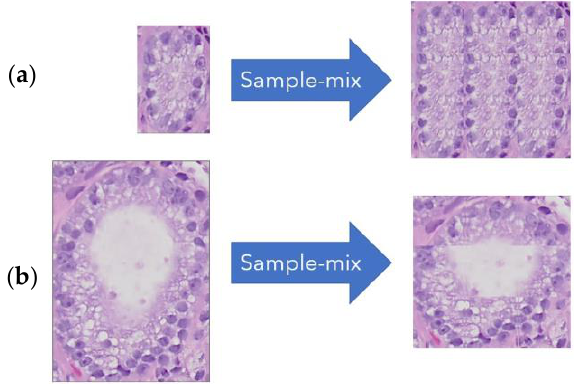
Figure 4. Sample-mix rescale examples: ( a ) 126 × 188 -> 300 × 300, ( b ) 290 × 417 -> 300 × 300.